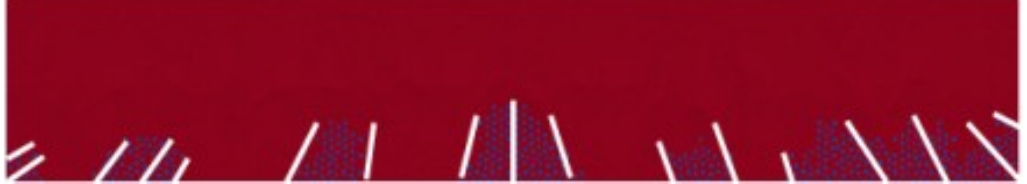
Figure 10. Flow network analysis of four‐point bending of a simply supported concrete beam.